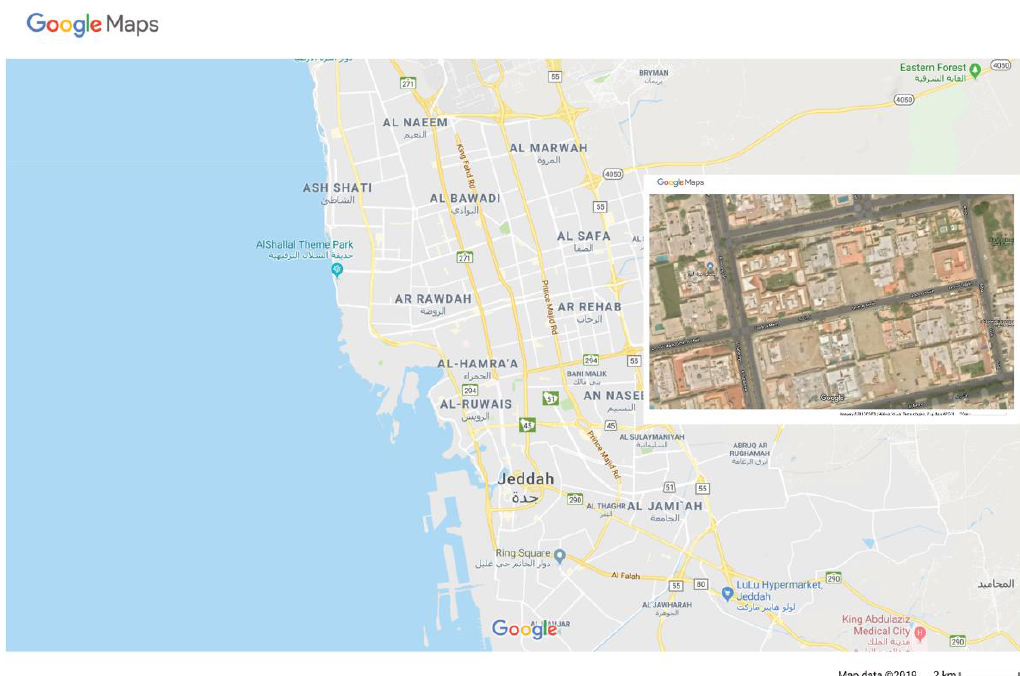
Figure 4. Villa 1 and 2 location in Jeddah on Google Maps.